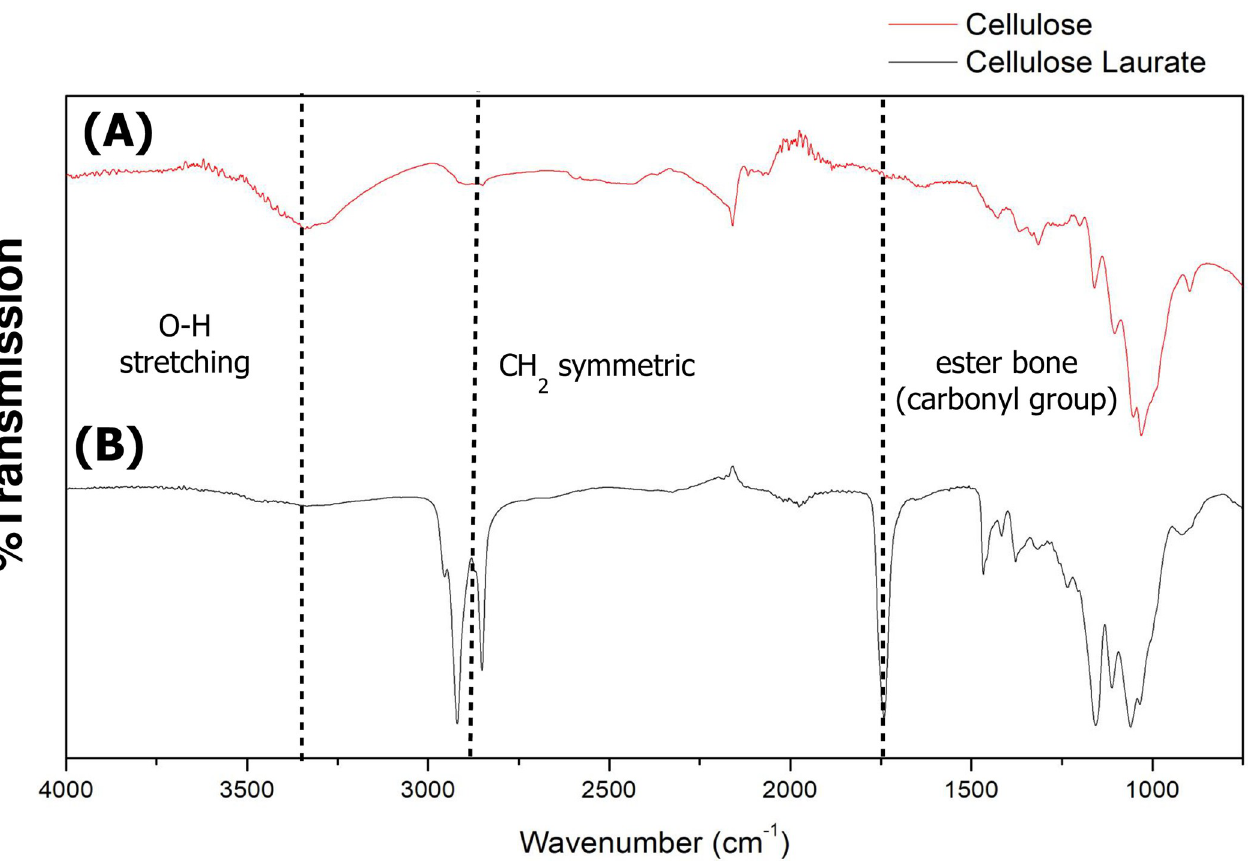
Fig 3. FTIR spectra of PALF-MCC and its esterification with fatty acid chloride. (A) FTIR spectra of native PALF-MCC and (B) esterified PALF-MCC laurate.